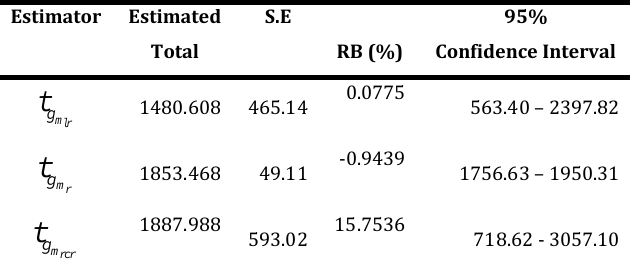
Table-3 represents the confidence interval for population total using standard error which generated through Jackknife variance estimator. For this purpose generate 4000 samples of size 200 and for each sample, we compute the Jackknife 95% confidence interval. According to those results, we are 95% confident to say that this interval will contain the true value of population total. It is important to note that the narrow intervals of estimators leads to a higher precision than wider intervals. The ratio estimator have narrow limits to each other than